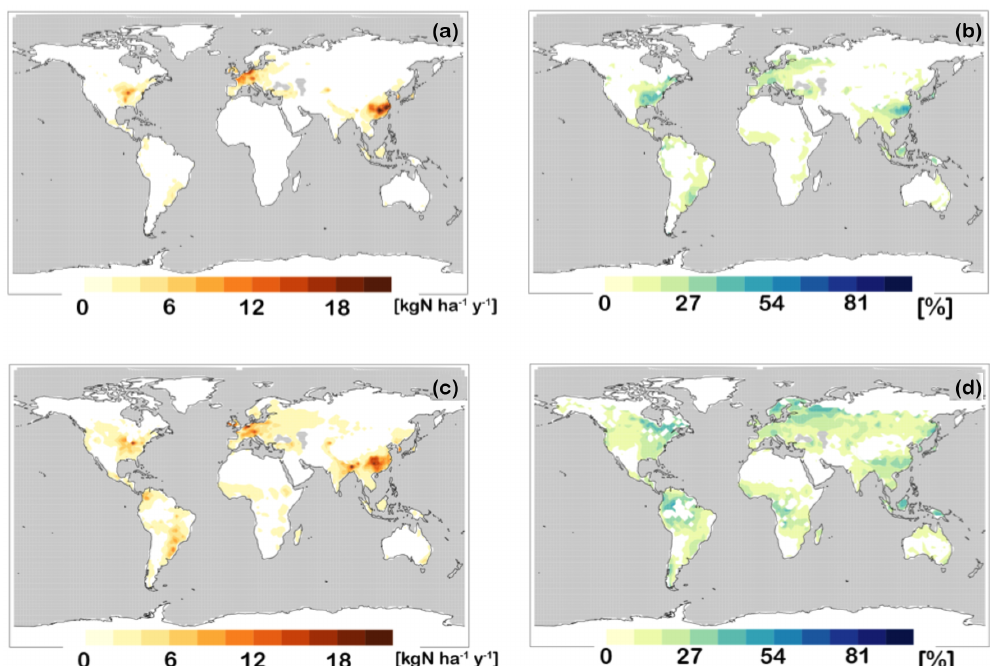
Figure 6. Simulated runoff of N r from synthetic fertilizer and manure TAN pools for the present-day (1995–2004) control simulation. Simulated runoff (kgNha − 1 yr − 1 ) as an annual average for (a) synthetic fertilizer, (c) manure. Simulated as (b) percent of annual synthetic fertilizer application, (d) percent of annual manure